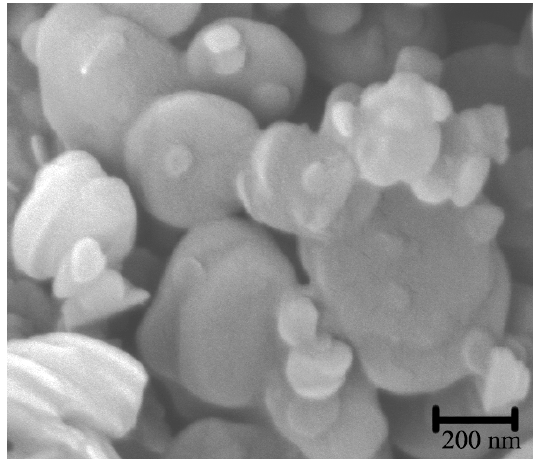
Figure 3. SEM image of the BN NPs.